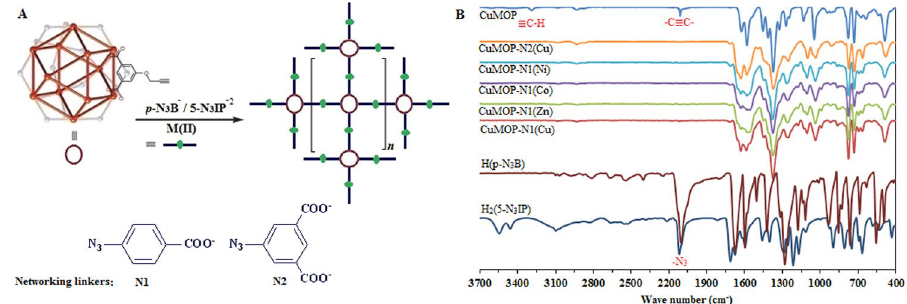
Figure 1. ( A ) Post-synthetic modification of alkyne-functionalized CuMOP into its extended networks using azide substituted organic bridging linkers ( 4 -azidobenzoate ( 4 -N 3 B − ) = N1 and 5-azidoisophthalate (5- N 3 IP − 2 ) = N2) via click reaction and their further coordination with metal(II) ions. ( B ) FTIR spectra of the H( p -N 3 B), H 2 (5-N 3 IP), CuMOP, and polymeric